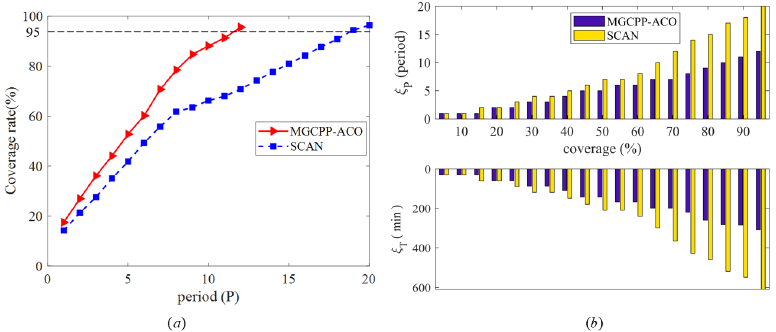
ξ and ζ of the two P T